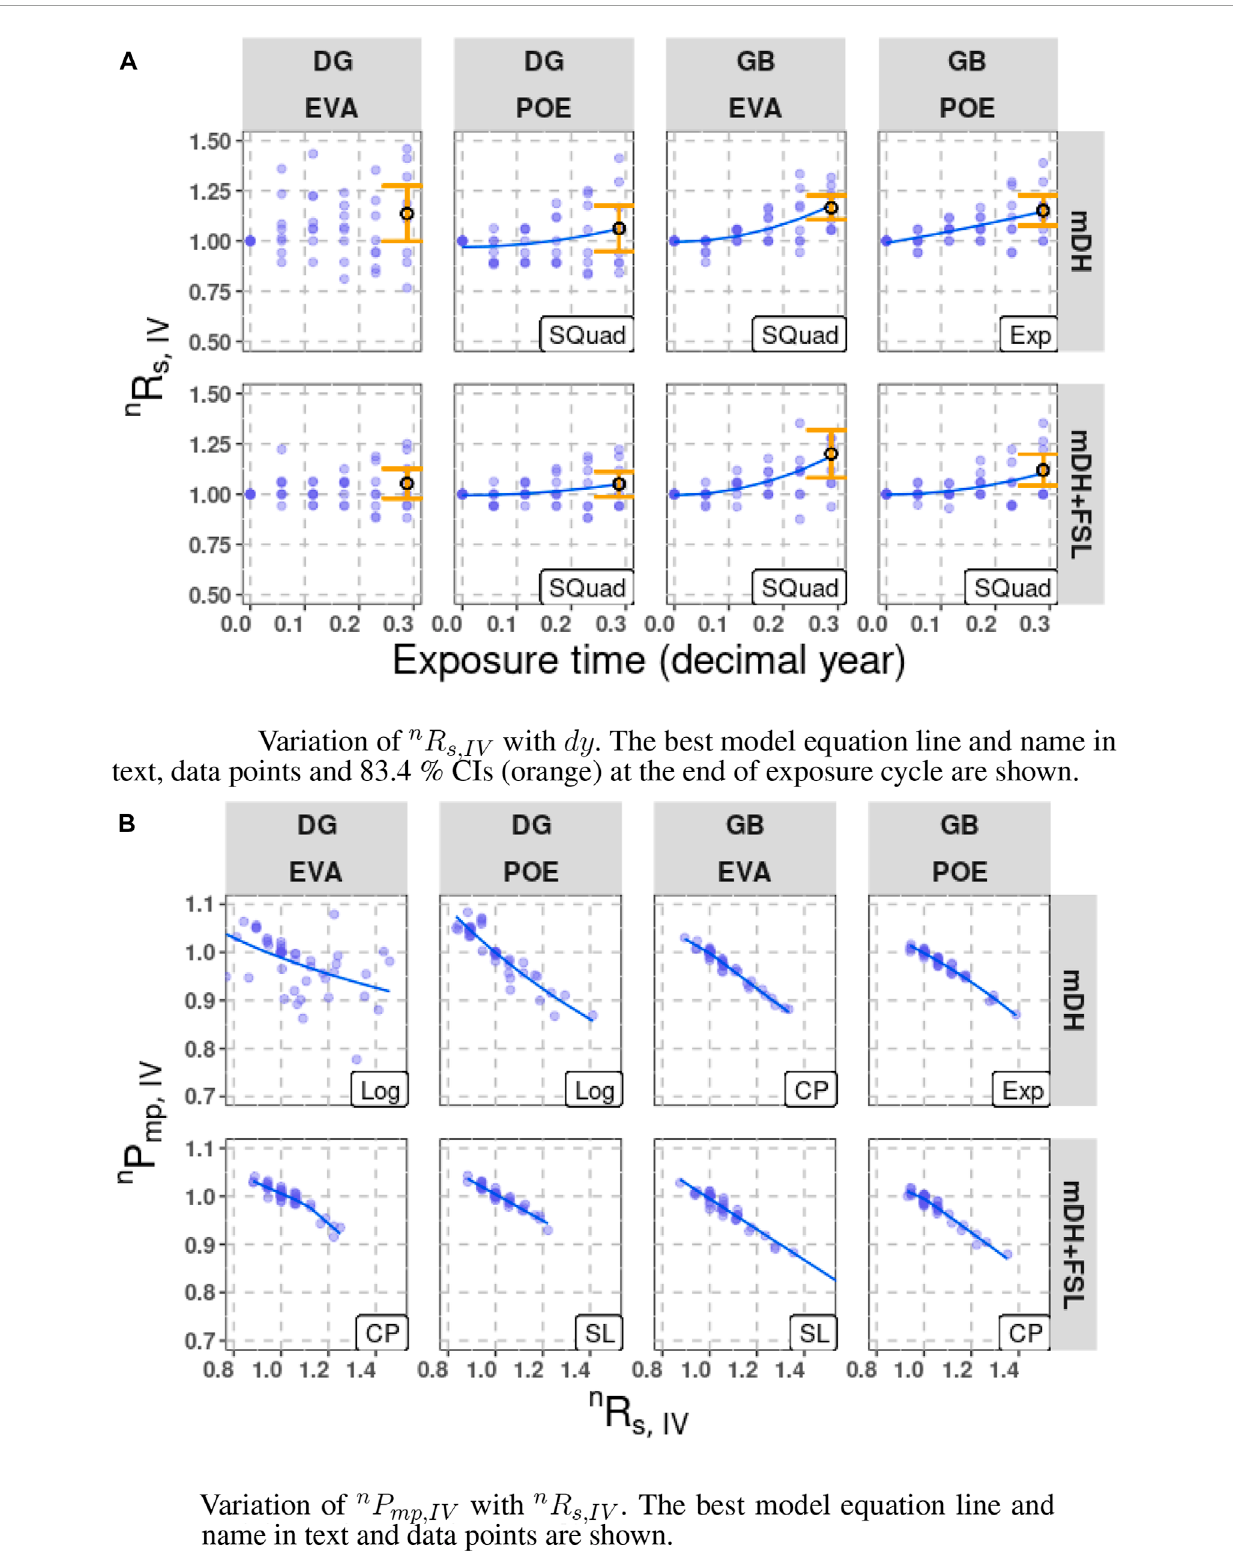
FIGURE 7 < S | M | and | M | R > (where mechanistic variable is n R s , IV ) results for minimodules manufactured by B. (A) Variation of n R s , IV with dy . The best model equation line and name in text, data points and 83.4% CIs (orange) at the end of exposure cycle are shown. (B) Variation of n P mp , IV with n R s , IV . The best model equation line and name in text and data points are